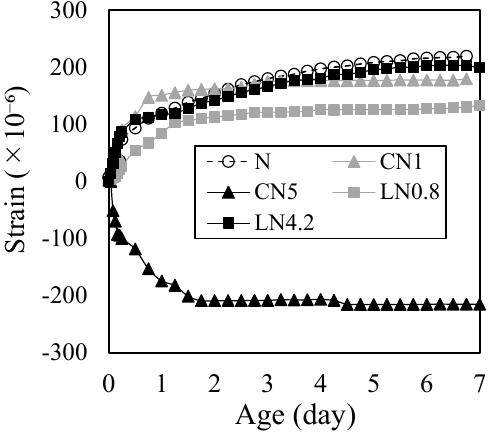
Figure 8. Autogeneous expansion and shrinkage (up to 7 days).